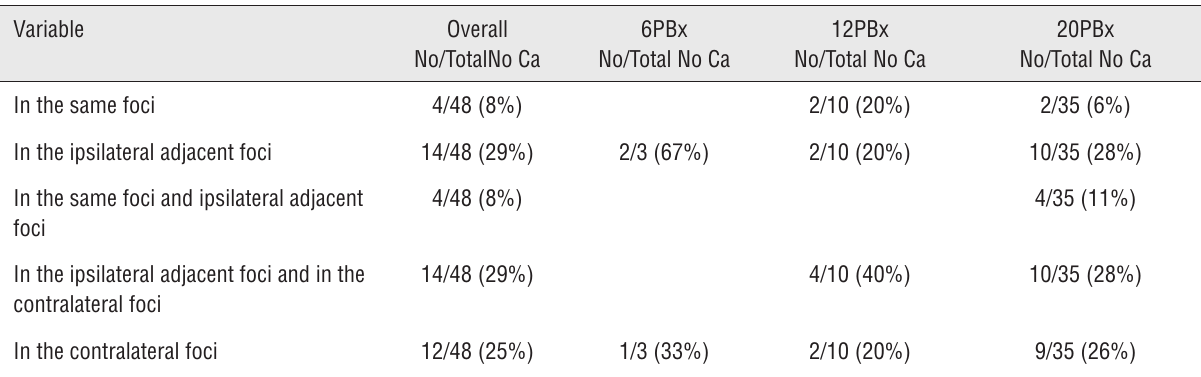
Table 4 - Localization of foci where cancer was detected in repeat prostate biopsy (according to ASAP foci in the initial prostate